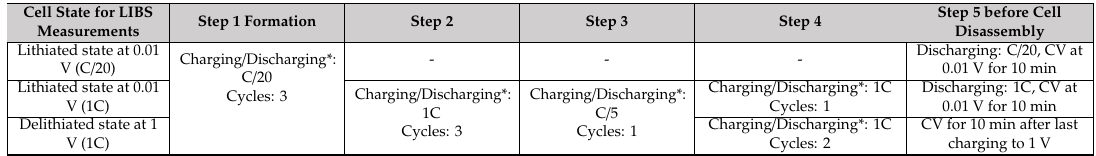
Electrochemical measuring procedures for laser-induced breakdown spectroscopy (LIBS)